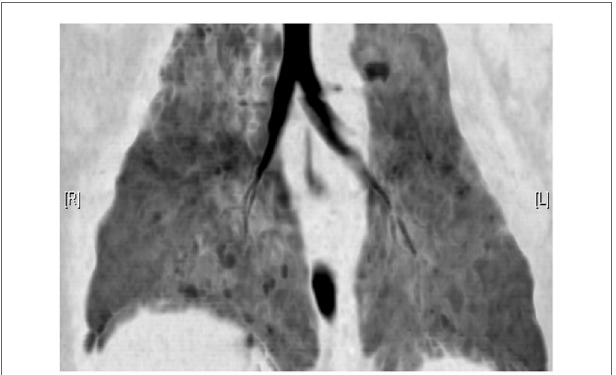
FigURe 3 | Vacuum immobilization device used to limit gross patient movement. Use of these devices, alongside ultrafast, high-pitch computed tomography, has dramatically reduced the need for general anesthetic or sedation for cardiothoracic CT at our institution.